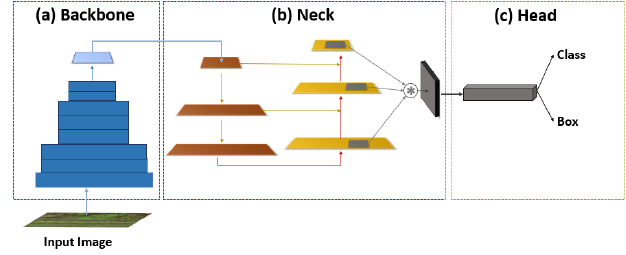
Figure 9. The network architecture of